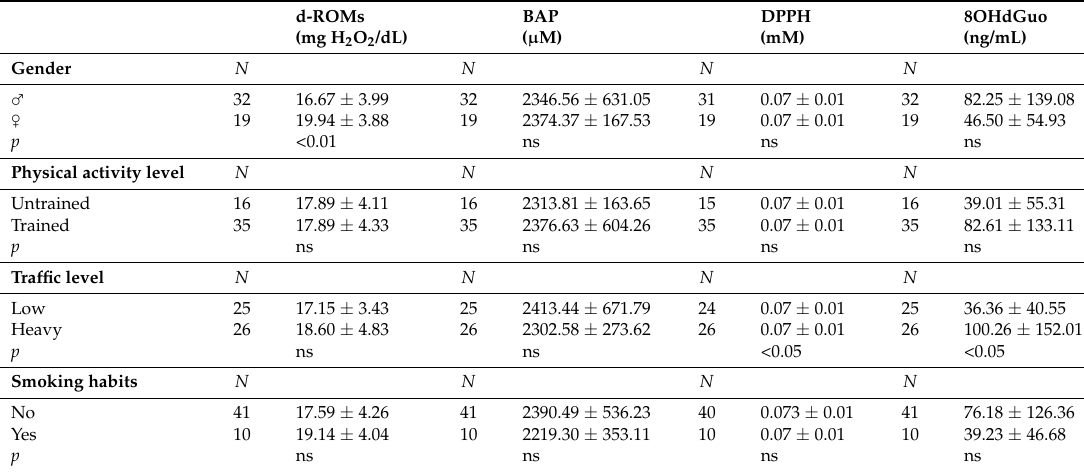
Table 2. Descriptive analysis of the OS parameters at rest condition of the whole group of participants (T rc time point) stratified by gender, environmental contributions and life styles (ns = not